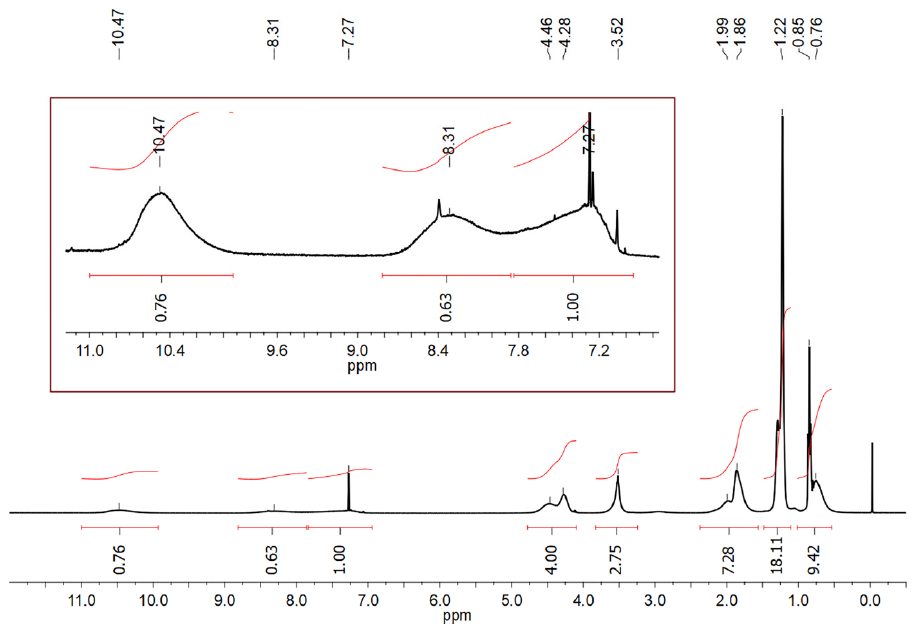
Figure 2. The 1 H NMR spectrum of DQ-POSS.